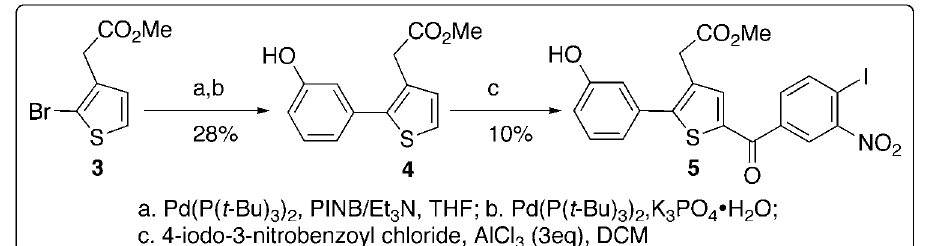
Figure 3. Synthetic scheme for intermediate 5.